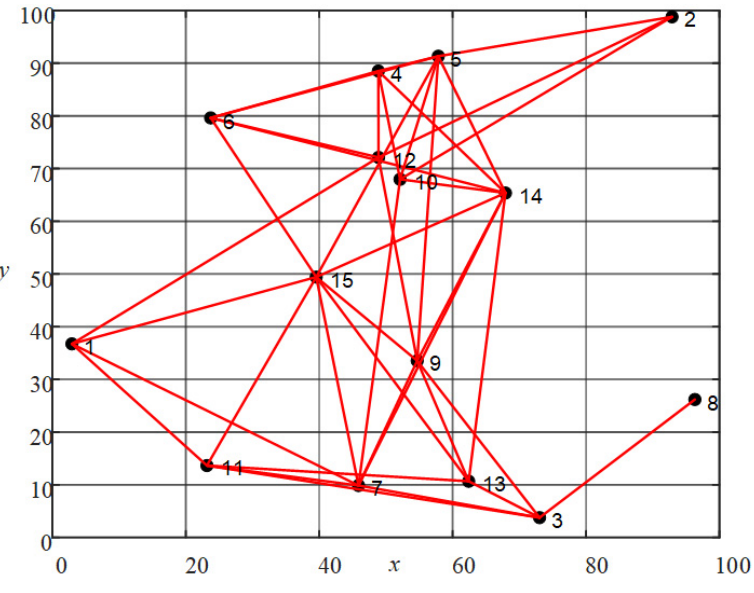
Figure 1. Original network topology.